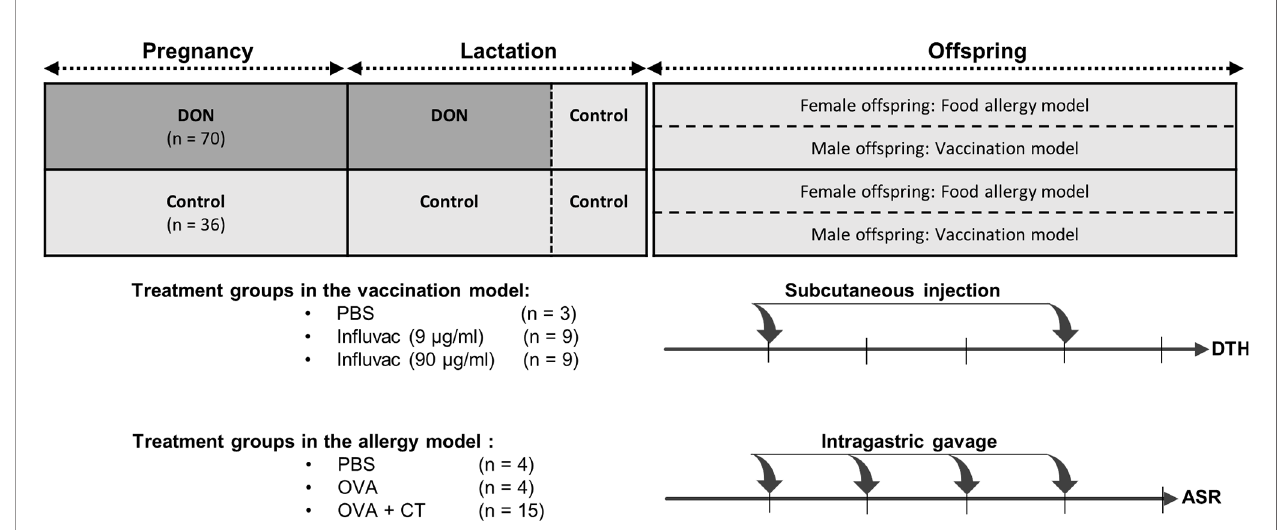
FIGURE 1 | Schematicoverview of study design.Femalemice received either control (AIN93) or Deoxynivalenol-contaminated(DON)diets duringpregnancy andlactation period,untila week before weaning. The offspring receivedcontrol diet right after weaninguntilthe end of the experiment, and were usedin either 1) vaccination model (male offspring),receiving2 injectionsof phosphate-buffered saline (PBS) or In fl uvac; or2)food allergy model (femaleoffspring), receiving intragastric gavage of PBS, ovalbumin (OVA)or OVA with cholera toxin (CT). The number ofanimals ineach group isindicated as n.At the end of the experiment, the animals invaccination model underwent delayed-typehypersensitivity (DTH)assay,and the animalsin food allergy model underwent acute allergic skin response